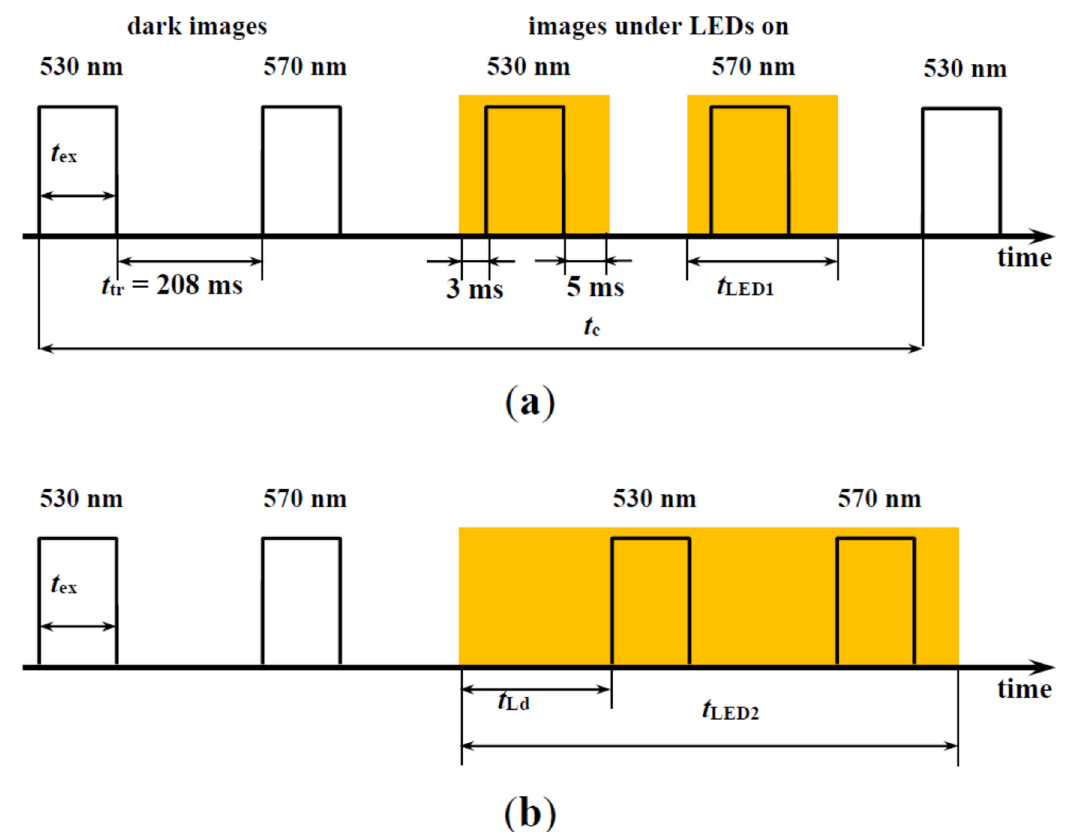
Figure 2. Duty cycles of PRI imaging system in two regimes: minimum illumination by GYL ( a ), and variable illumination by GYL ( b ). Cycle duration of the first regime, t c, is 872 ms, exposure time, t ex , is set to 10 ms for all CCD frames, the delay between frames, t tr , is set to 208 ms for data transferring, the delay time between LEDs on and starting frame capture is set to 3 ms to exclude transition processes of LEDs during frame exposure, LEDs pulse duration in the first regime, t LED1 , is set to 18 ms, in the second regime LEDs pulse duration, t LED2 , is changes by varying the delay between LEDs on and frame capture in the second regime, t Ld . Dark images are measured under background illumination; measuring images are measured under GYL illumination and the background illumination. In our paper, the background illumination included the measuring light and actinic light, which were used for measurements of chlorophyll fluorescence (see Section 2.3 for details).